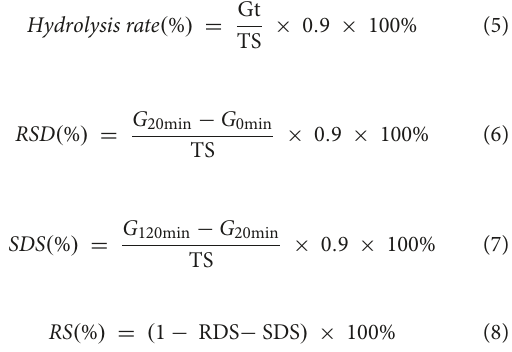
Figure 3 . The starch granule structure of LS-0CS